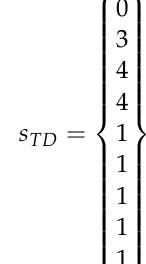
Figure 14. Normalized reward components versus decision epochs for the well. Figure 15 shows the state of the system at the end of the drilling operation (12.25 inch hole section), which can be represented by Equation (22). The mud properties for drilling the last section of the well were: mud density of 9.06 ppg, PV of 11 cP, and YP of 36.5 lbf/100 ft 2 . The final bed height was around 9 inches, which needed to be significantly reduced.